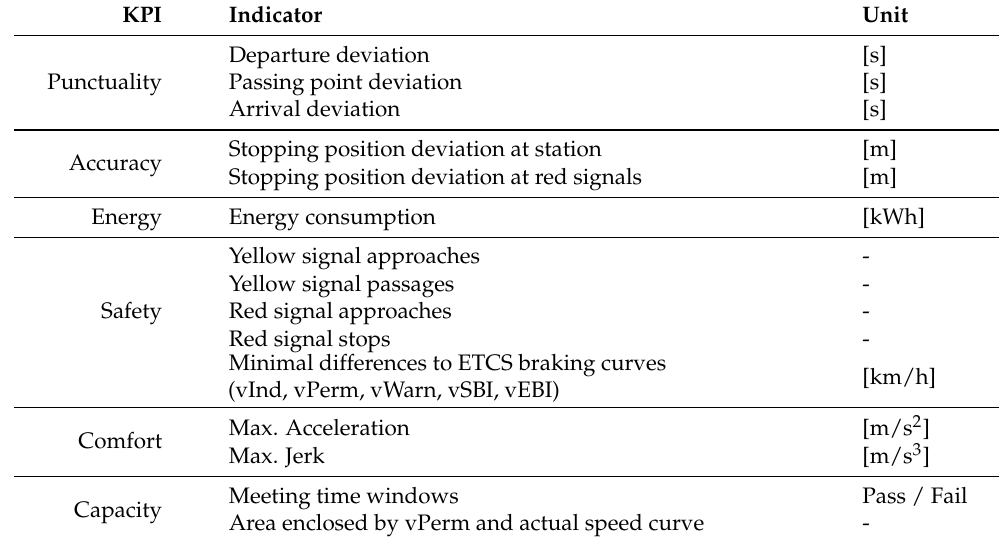
Table 1. List of KPIs for the evaluation of the performance of ATO